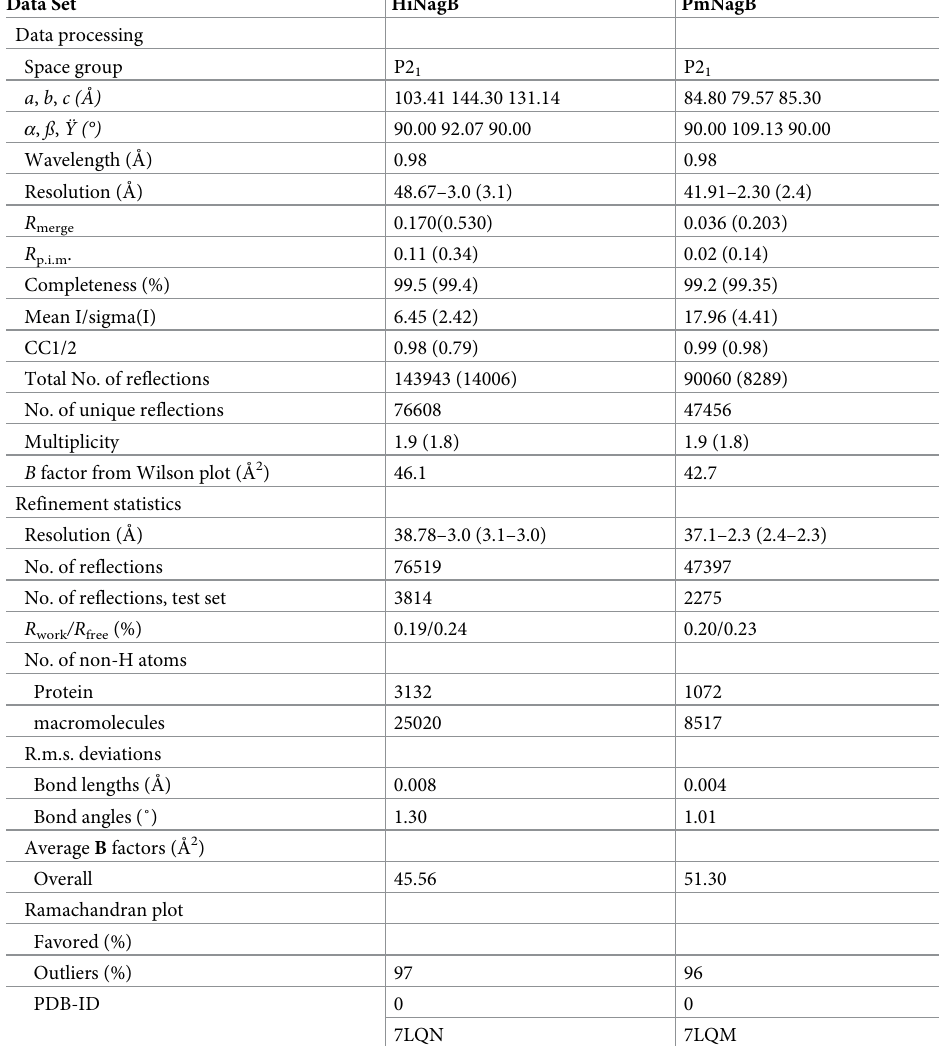
Table 1. Data-processing and refinement statistics. Values in parentheses are for the highest resolution shell. Data